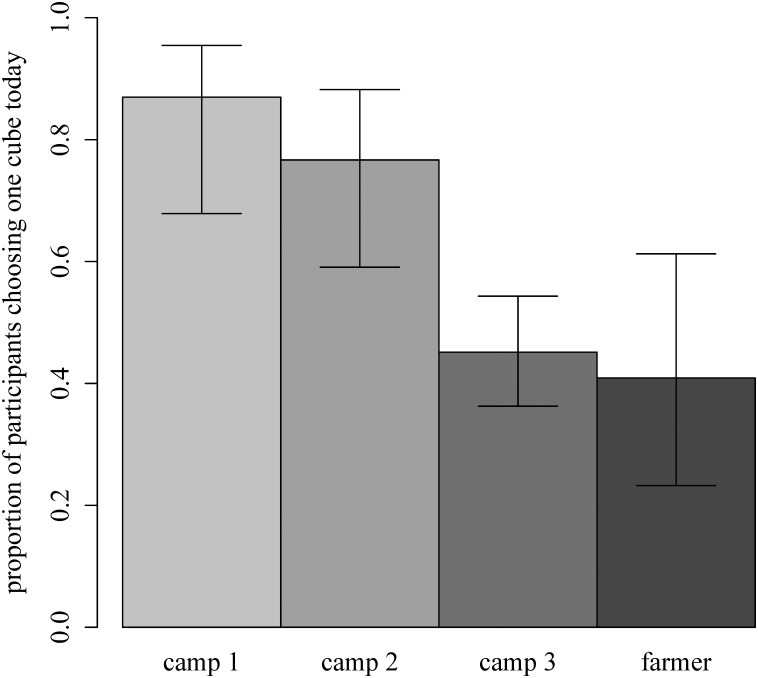
Proportion of participants that chose to receive one cube today in 3 Mbendjele camps and one Bantu farmer village.Camp 1 and camp 2 were located in the forest; camp 3 was located in the town. Error bars indicate 95% confidence intervals.